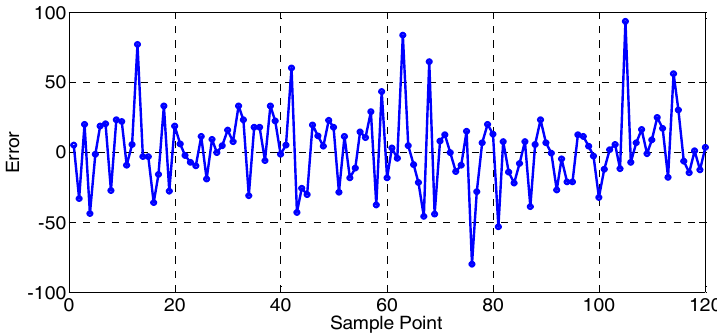
Figure 14. The cross-validation analysis.